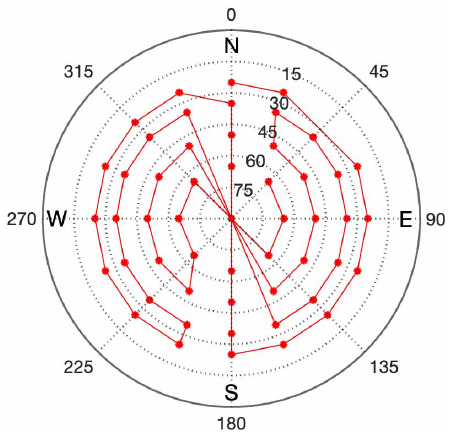
Figure 4. One cycle of the WVR observations consists of 52 ob- servations. The cycle is repeated every 5min. Note that the zenith point is only measured once, the first time it passes over